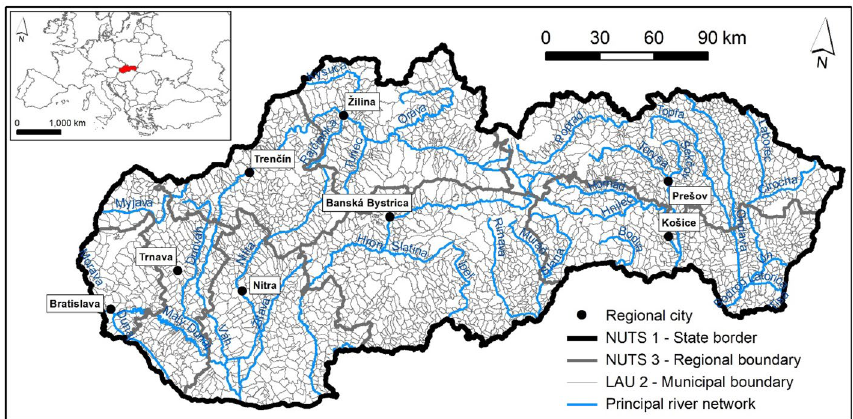
Figure 1. Research area: Slovakia—2927 municipalities (LAU 2 level). This figure was generated in ArcGIS 10.2.2